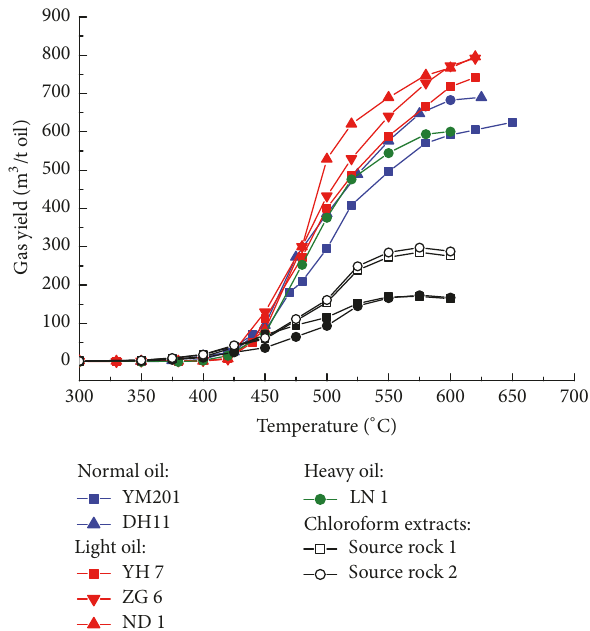
Figure 5: The volume production of gaseous hydrocarbons from liquid hydrocarbons with different compositions (heating rate: 20 ∘ C/min, 50 MPa).